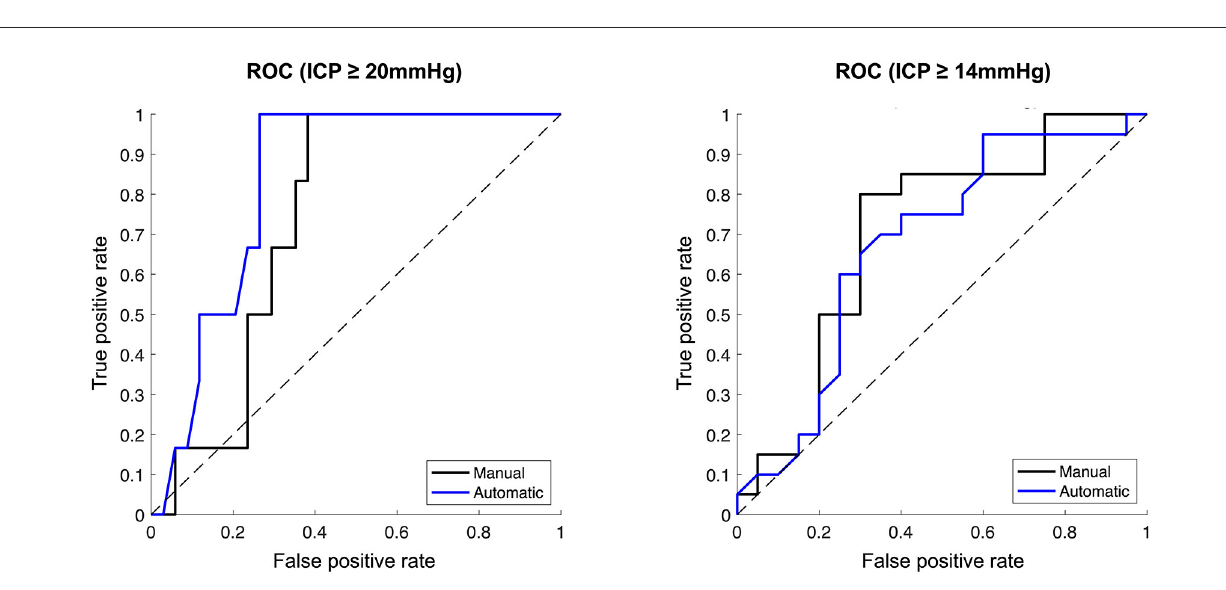
FIGURE4 Ability of manually vs. automatically measured optic nerve sheath diameter to distinguish dichotomised ICP. Receiver operator characteristic curves. (Left) ICP dichotomised at ≥ 20 mmHg. (Right) ICP dichotomised at ≥ 14 mmHg. Manual ONSD measurements represented by black lines, automatic ONSD measurements represented by blue